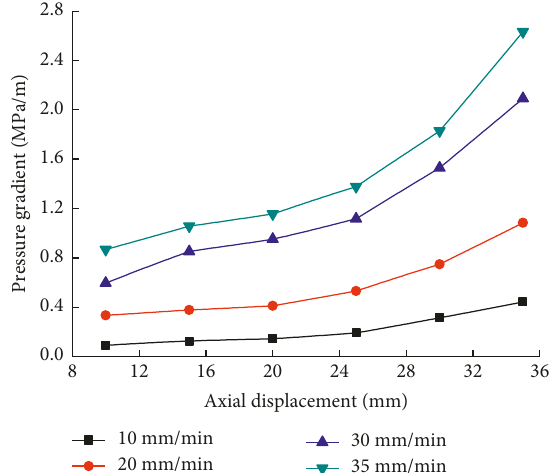
Figure 7: Axial displacement and corresponding pressure gradient of specimen A (1 :0) under different piston velocities. Table 2: Porosity ( φ ) and permeability ( k ) at various axial displacements for all the specimens. Specimen number Properties